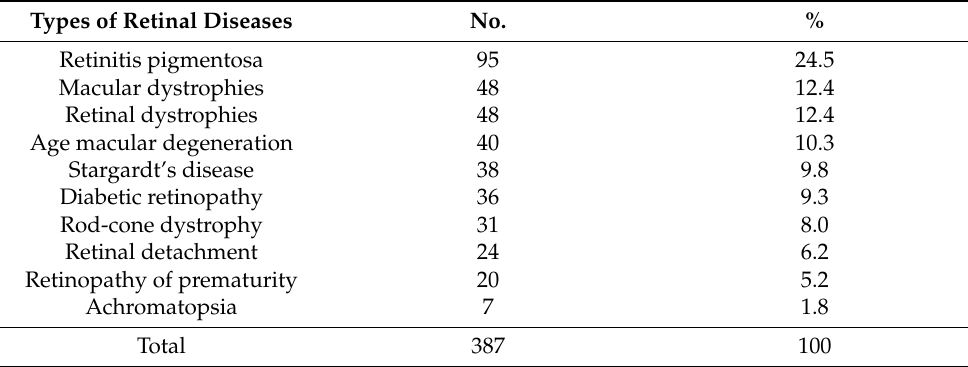
Table 3. Frequencies of occurrence for different types of retinal